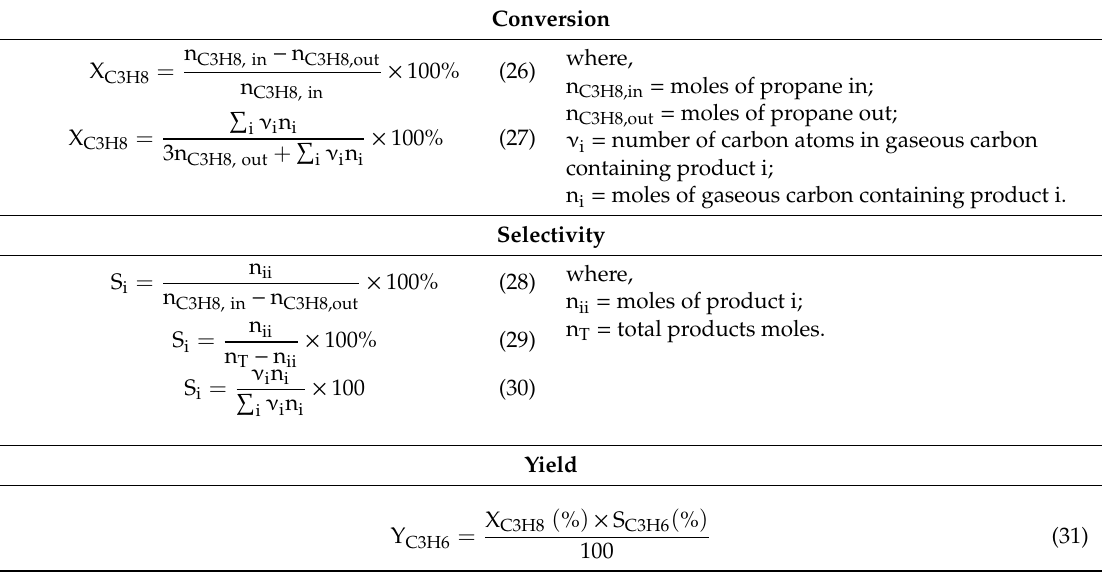
Table 2. Propane Conversion, Propylene Selectivity, and Propylene Yield